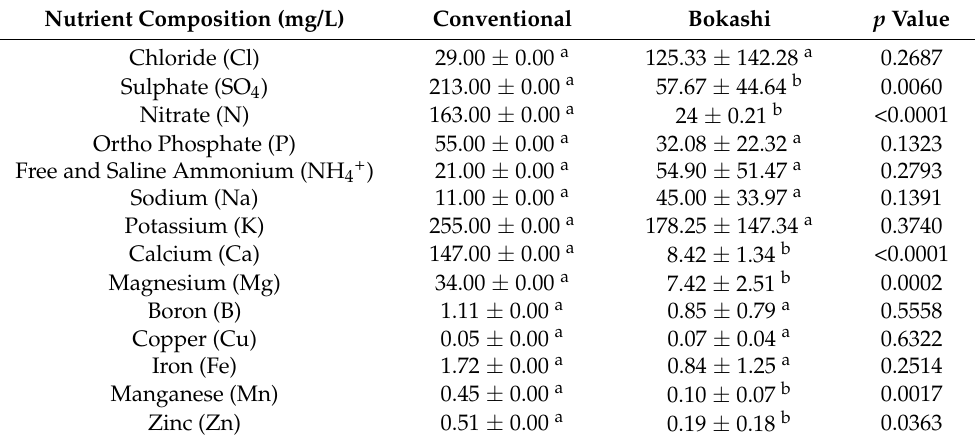
Table 1. Mineral nutrient analysis of leachate from 10% bokashi compost and conventional commer- cial hydroponic